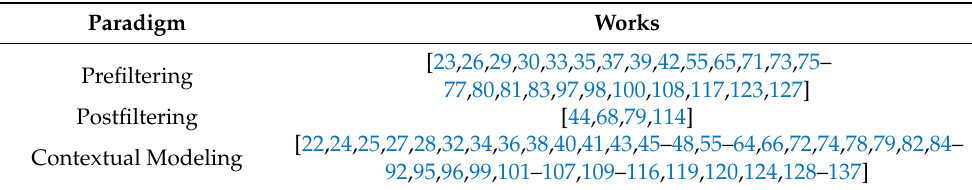
Table 4. Contextual paradigms for using context in